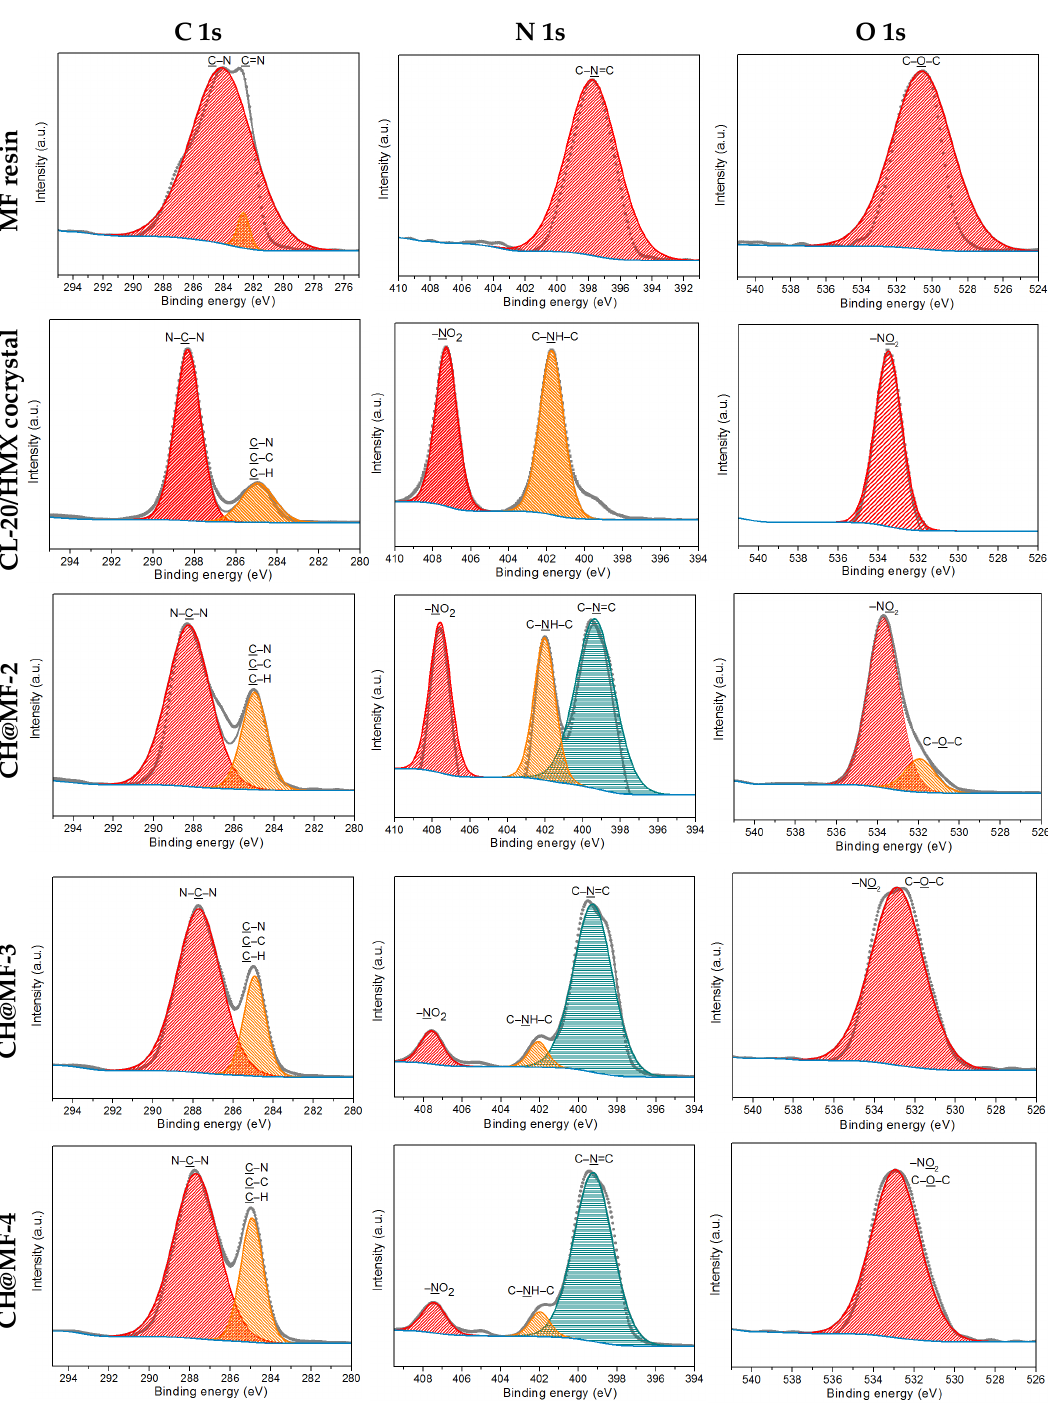
Table 2. Surface element composition of the MF resin, CL-20/HMX cocrystal and CH@MF compo- sites.